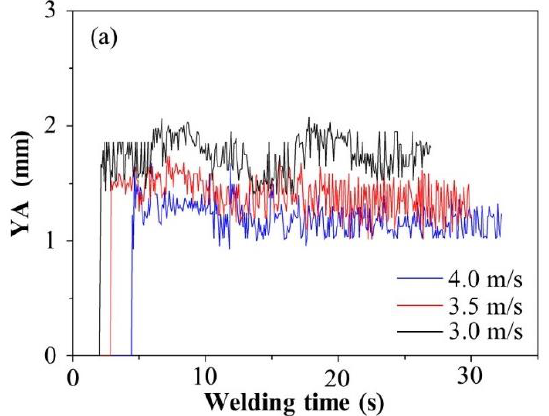
Figure 7. Images after edge fitting of the keyhole under different welding speeds: ( a ) 4.0 mm/s, ( b ) 3.5 mm/s, ( c ) 3.0 mm/s.